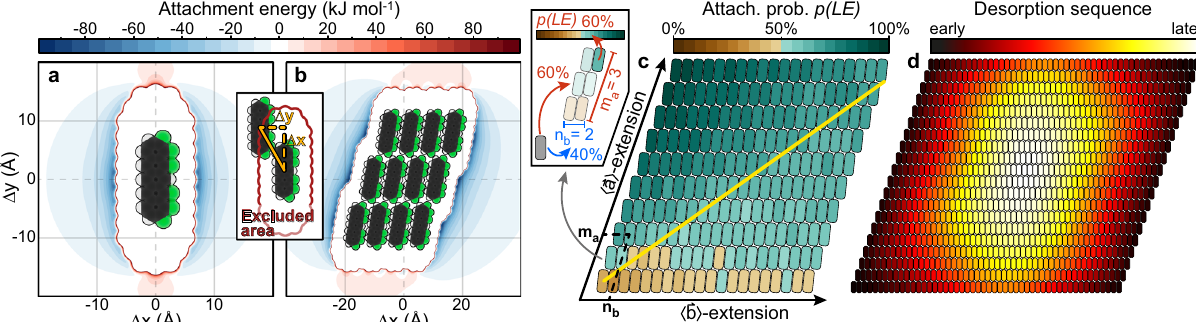
* 〉 ,asfunctionoftheislandshape m a × n b .Notethat p( LE ) =1 – p( SE ) .The Fig. 2 | Computational analysis of L-F6PEN nanosheet formation. direction 〈 b a , b Attachment energy maps (AEMs) for a single L-F 6 PEN molecule and a 3×4 yellow line marks a geometrical aspect ratio of the nanosheets of 1:1. Inset: Illu- island of L-F 6 PEN molecules, respectively, probed by an equally oriented L-F 6 PEN stratedreadinginstructionforthemap.Thecolourofthemoleculeinthetopright molecule. Inset: Illustration of the boundary of the excluded area (red) that marks cornerof theexemplary3×2island denotes p (LE)forthisislandshape,inthiscase relative displacements that are physically inaccessible due to Pauli repulsion. 60%. d MapofthedesorptionsequenceofL-F 6 PENmoleculesfroma20×50island c Probability p( LE ) forattachmentofanL-F 6 PENadmoleculetoalongsideedge(LE) averaged from 50 simulated temperature-programmed desorption * 〉 and n b molecules in for a given island shape of m a molecules in direction 〈 a